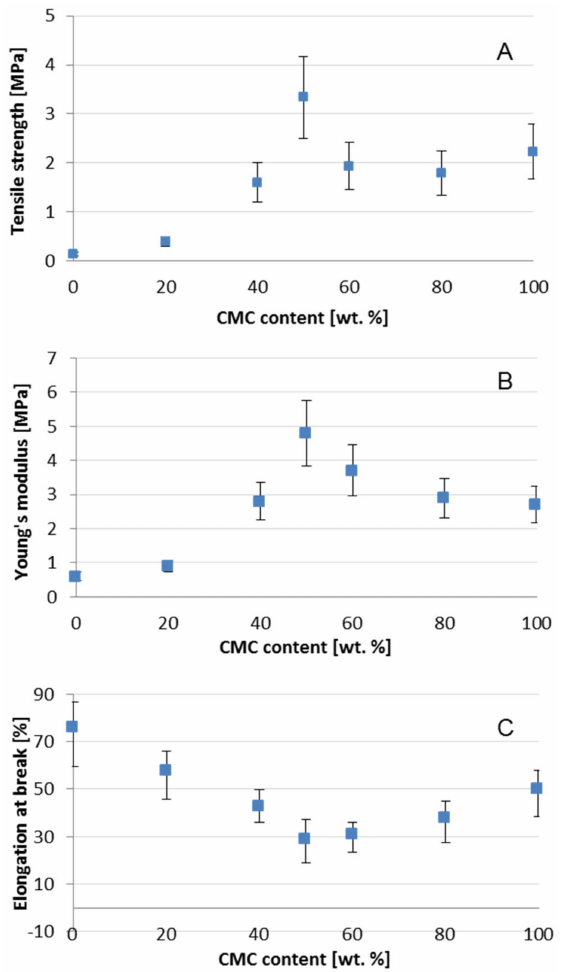
Figure 10. Tensile strength ( A ), Young’s modulus ( B ) and elongation at break ( C ) of CMS / CMC